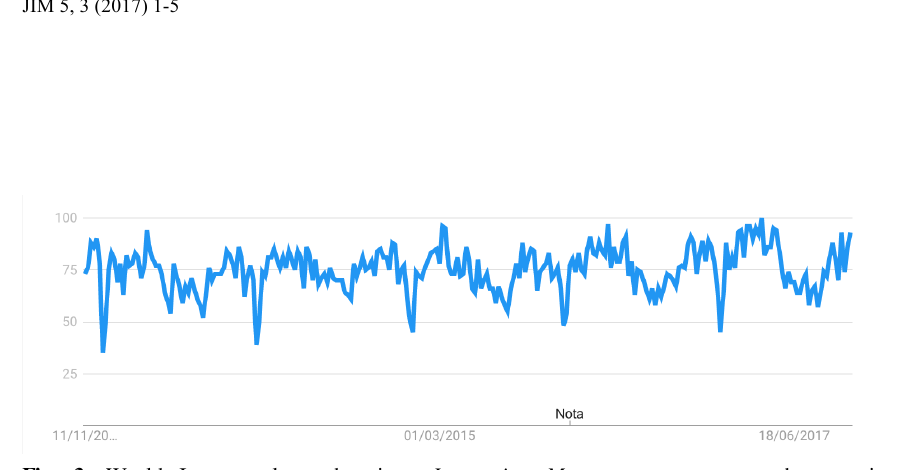
Fig. 3. World Interest along the time. Innovation Management as a search term in https://trends.google.com for the last five years. 100% translates a peak of popularity.